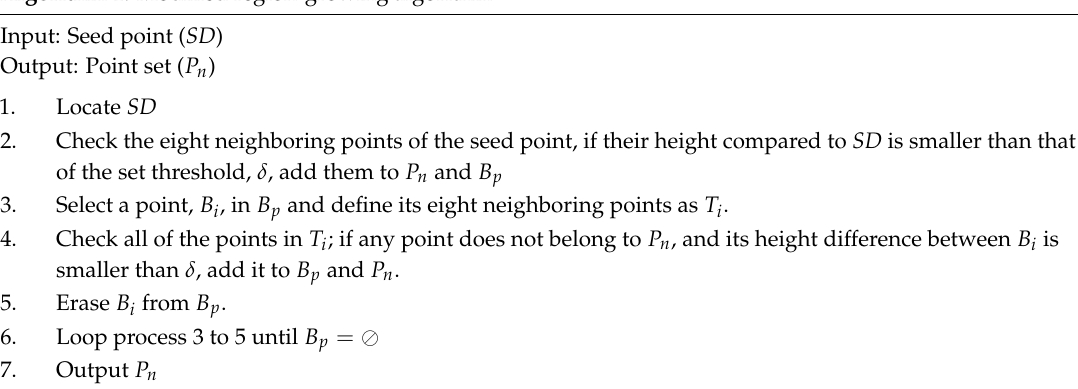
Algorithm 1. Modified region-growing